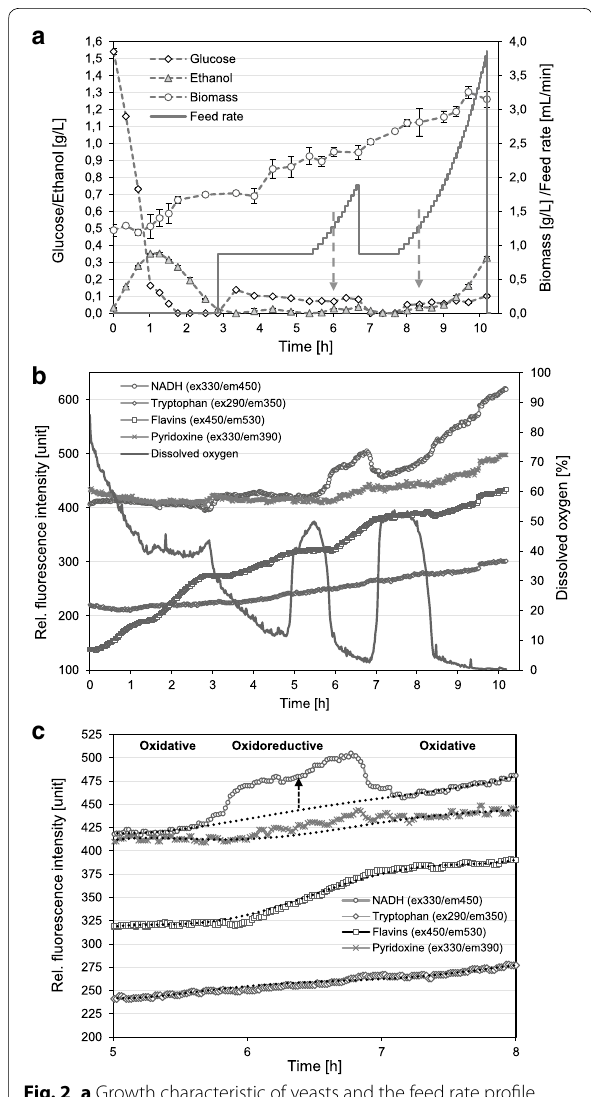
Fig. 2 a Growth characteristic of yeasts and the feed rate profile during the fed-batch operation without a closed-loop control. The arrows point out the produced ethanol due to overflow metabolism. b Evolution of the dissolved oxygen and the intensity of NADH, tryptophan, flavins, and pyridoxine during the fed-batch operation without a closed-loop control. c Characteristics of the fluorophores in different metabolic states of oxidative and oxidoreductive metabo- lism. The dotted lines are plotted from the polynomial function based on the state of oxidative metabolism to see the intensity change between these two metabolic states. The small arrow shows the dif- ferent intensity between the oxidative and oxidoreductive